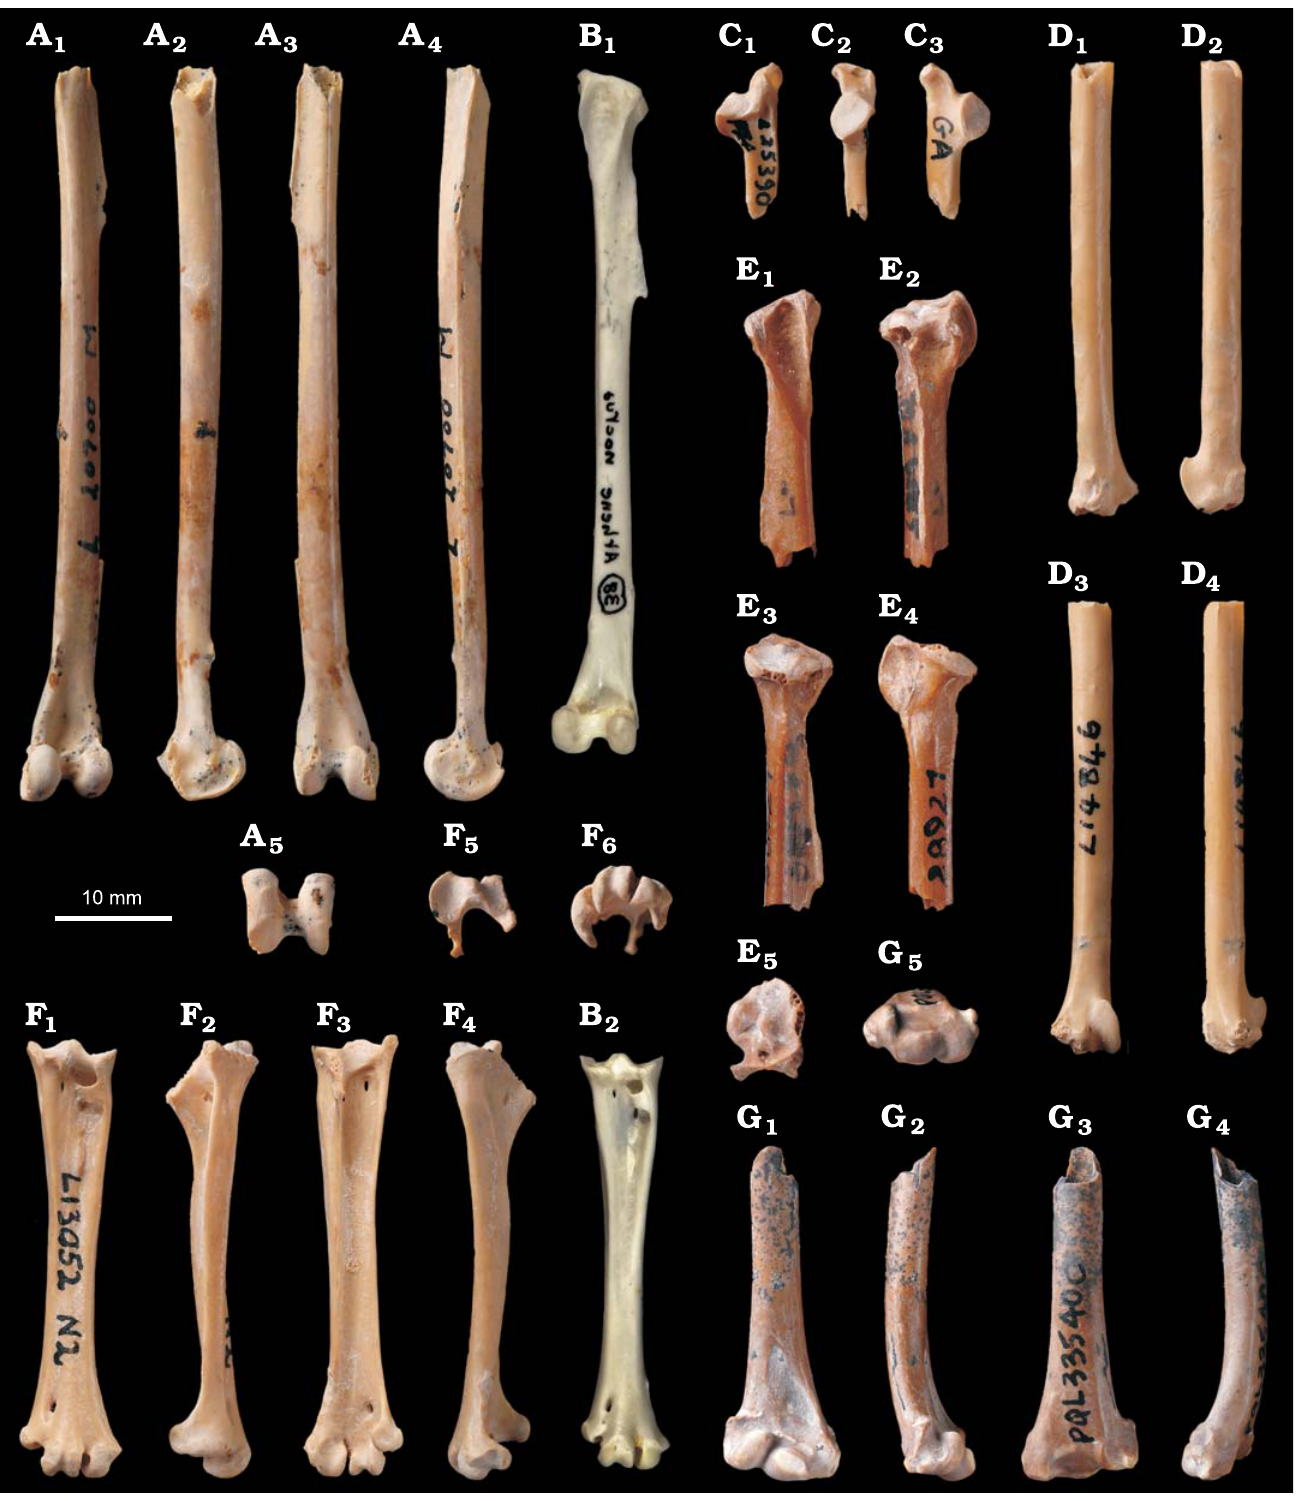
Fig. 2. Strigid owl Athene inexpectata sp. nov. from the early Pliocene, Upper Varswater Formation at Langebaanweg, South Africa; paratypes ( A , C – E , G ), holotype ( F ) and Athene noctua , Recent ( B ). A . Left tibiotarsus (SAM-PQ-L20700 M), in cranial (A ), lateral (A ), caudal (A ), medial (A ), 1 2 3 4 and distal (A ) views. B . Reversed right tibiotarsus (MGPT-MPOC 38), in cranial view (B ), left tarsometatarsus in dorsal view (B ). C . Left scapula 5 1 2 (SAM-PQ-L25390 GA), in medial (C ), cranial (C ) and lateral (C ) views. D . Right ulna (SAM-PQ-L14846), in dorsal (D ), caudal (D ), ventral (D ) 1 2 3 1 2 3 and cranial (D ) views. E . Right tibiotarsus (SAM-PQ-L28927), in cranial (E ), lateral (E ), caudal (E ), medial (E ), and proximal (E ) views. F . Right 4 1 2 3 4 5 tarsometatarsus (SAM-PQ-L13052 N2), in dorsal (F ), lateral (F ), plantar (F ), medial (F ), proximal (F ), and distal (F ) views. G . Right humerus (SAM- 1 2 3 4 5 6 PQ-L33540 C), in cranial (G ), dorsal (G ) caudal (G ), ventral (G ), and distal (G ) 1 2 3 4 5